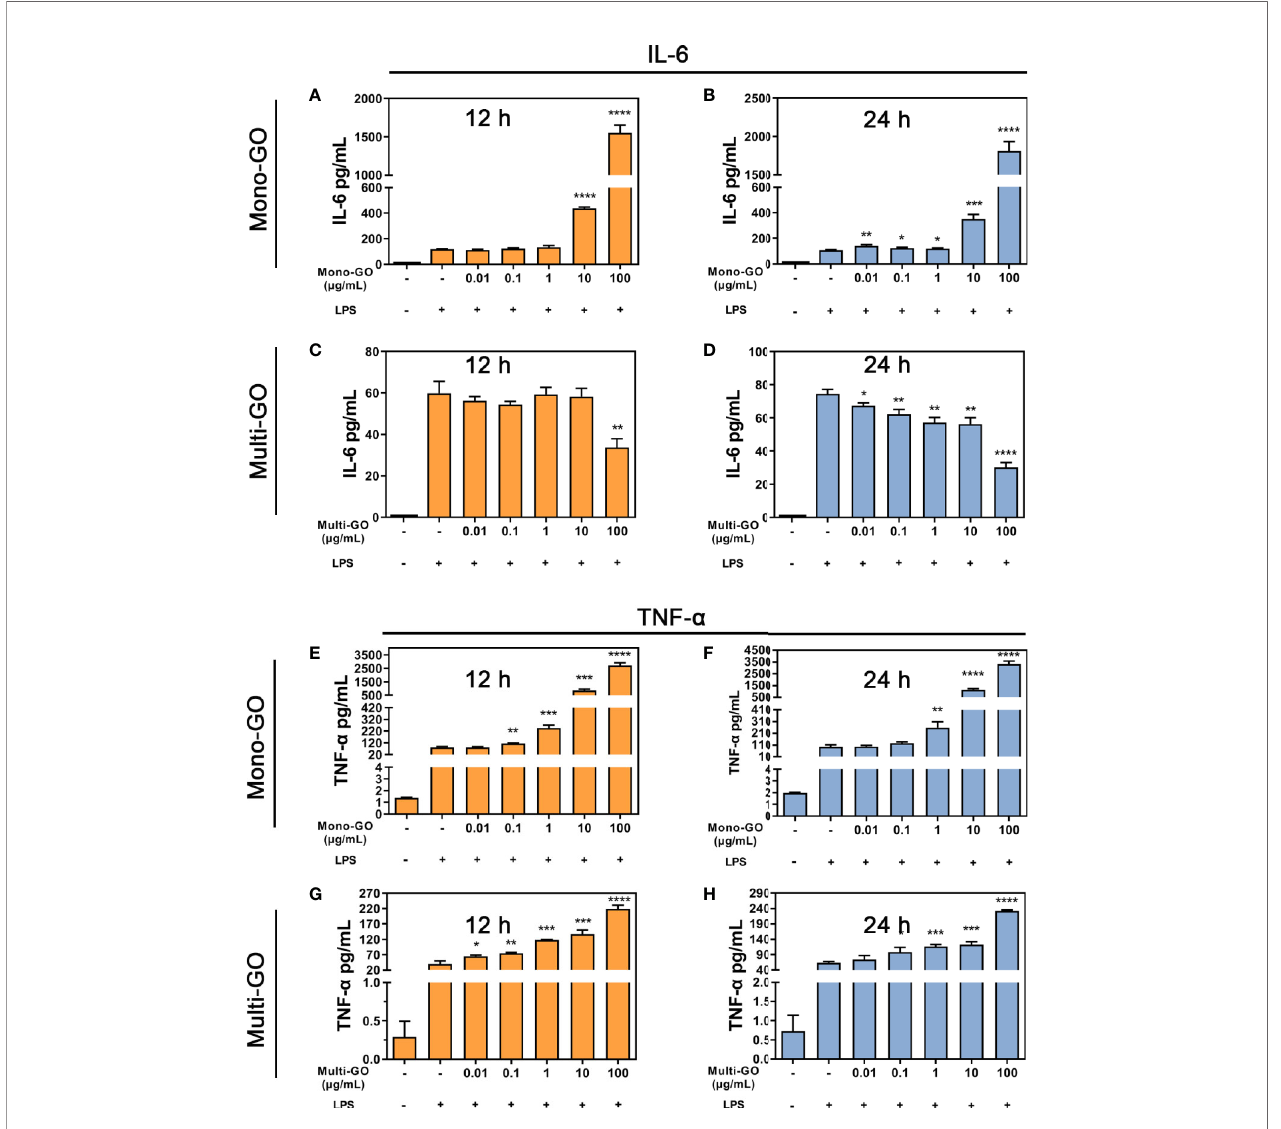
FIGURE 4 | Mono – graphene oxide (GO) or multi-GO promotes or inhibits lipopolysaccharide (LPS)-induced IL-6 and TNF- a cytokine secretion. (A, B, E, F) DC2.4 were treated with mono-GO (10 m g/ml, 4 h) before the addition of LPS (1 m g/ml, 12 h or 24 h; n = 3). (C, D, G, H) DC2.4 were treated with multi-GO (10 m g/ml, 4 h) before the addition of LPS (1 m g/ml, 12 h or 24 h; n = 3). *P < 0.05; **P < 0.01; ***P < 0.001; ****P < 0.0001 vs.